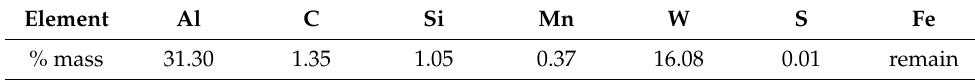
Table 3. Chemical composition of the investigated cast iron. Element